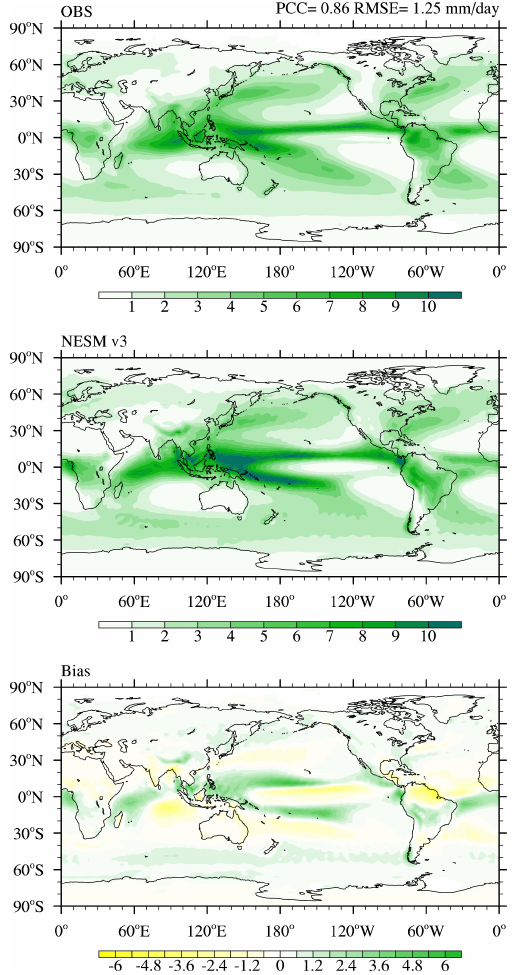
Figure 9. The climatological mean precipitation (mmday − 1 ) in ob- servations, NESM v3, and model bias. The observed precipitation was derived from a merged precipitation dataset (Lee and Wang, 2014), which is the arithmetic mean of the monthly data from the Global Precipitation Climatology Project (GPCP) version 2.2 (Adler et al., 2003) and Climate Prediction Center Merged Analysis of Precipitation (CMAP; Xie and Arkin,